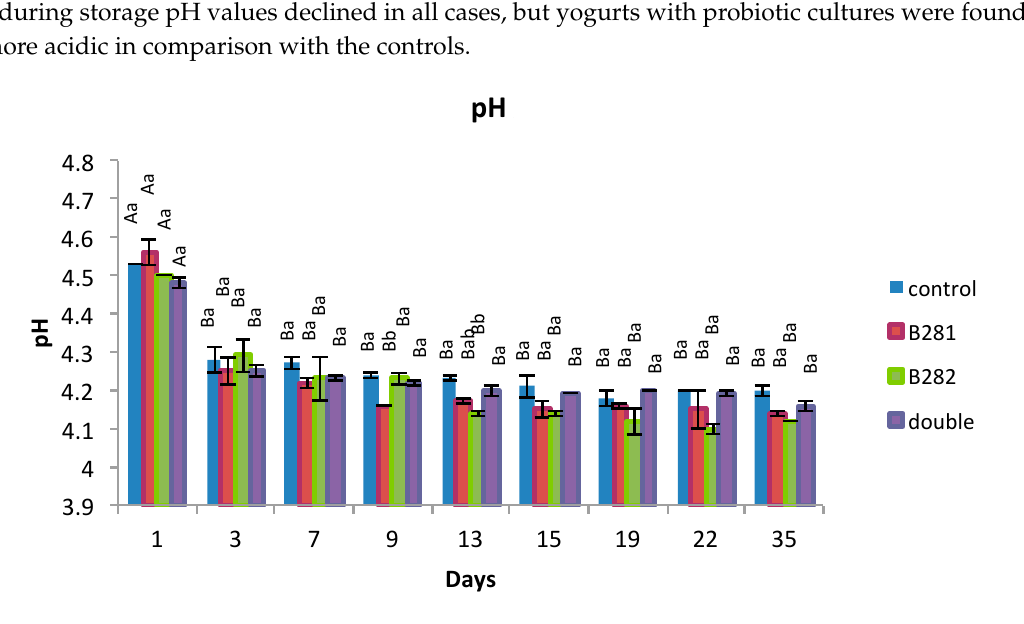
Figure 4. pH Values in yogurt samples during refrigerated storage. Means with different uppercase letters within the same treatment are significantly different ( p < 0.05). Means with different lowercase letters within the same storage day are significantly different ( p < 0.05).